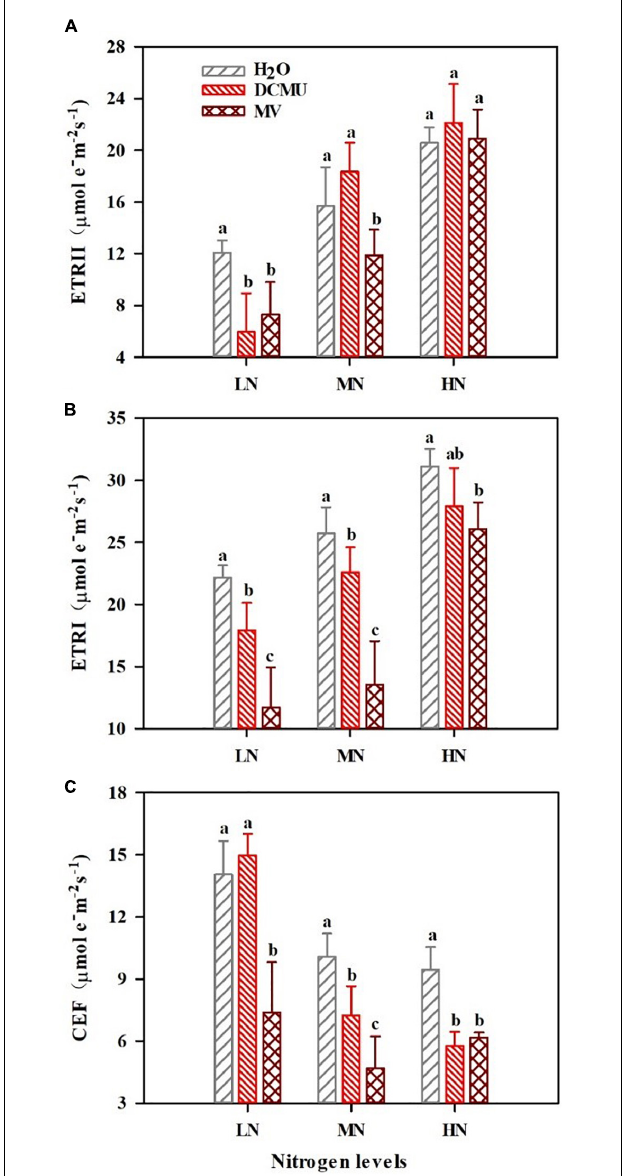
FIGURE 4 | Effects of 3-(3,4-dichlorophenyl)-1,1-dimethyl urea (DCMU) and methyl viologen (MV) on ETRII, ETRI, and cyclic electron flow (CEF) in leaves of Panax notoginseng grown under different nitrogen regimes. (A) ETRII is the electron transport rate of PSII. (B) ETRI is the electron transport rate of PSI. (C) CEF is the cyclic electron flow. Values for each point were mean ± SD ( n = 5). Different letters indicate significant differences among treatments ( p <